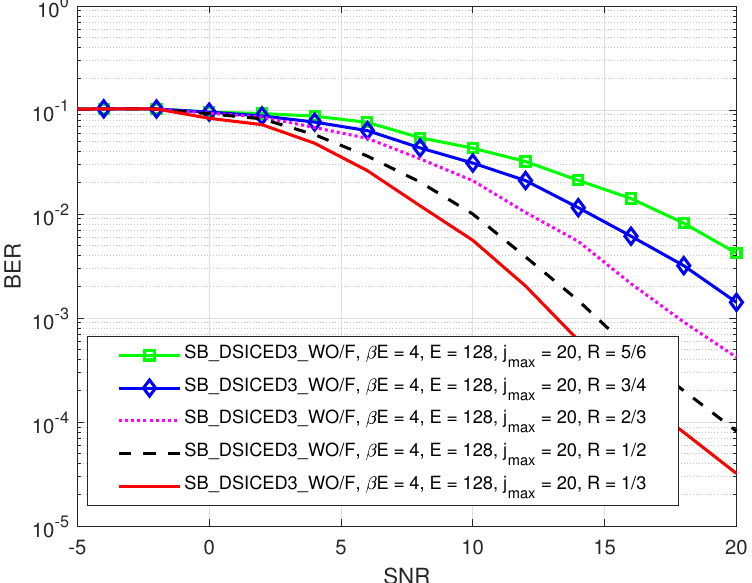
Figure 7. BER versus SNR, p B / σ 2 w for different code rates R of the SB_DSICED3_W/OF scheme; j max = 20, p SI / σ 2 w = 30 dB, β E = 4 symbols, and E = 128 symbols.